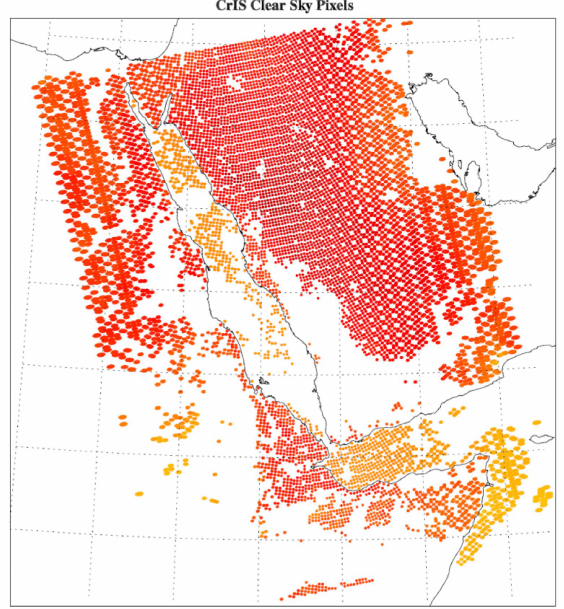
Figure 10. CrIS clear sky FOVs’ BTs detected using VIIRS cloud mask product. The original CrIS and VIIRS images as well as the color bar can be found in Figure 2.